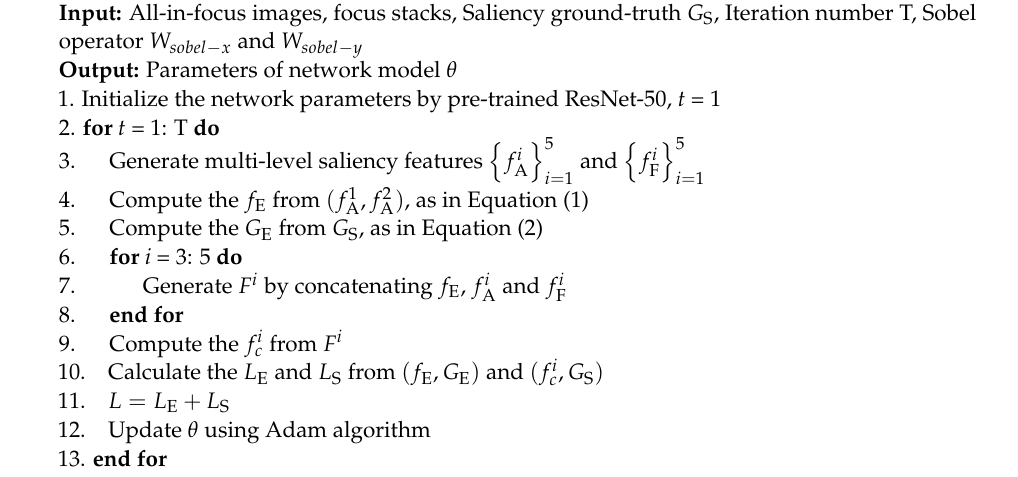
Algorithm 1. High Edge-Quality Light-Field Salient Object